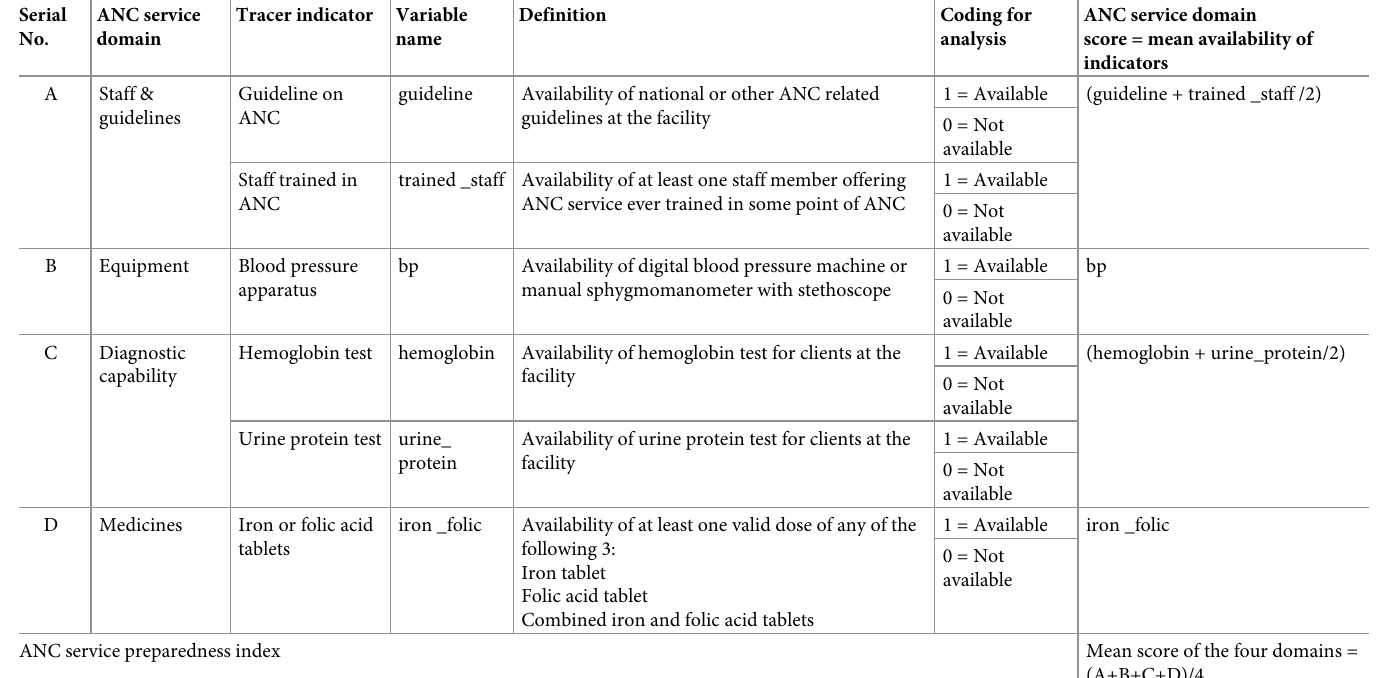
Table 1. Measurement procedure of outcome variable “ANC service preparedness”. Serial